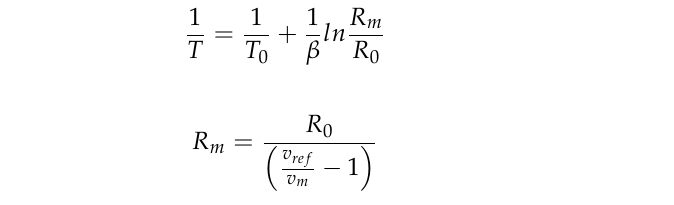
Figure 4. An in vivo measurement setup: ( a ) implanted coils underneath the skin, and ( b ) primary coils adhered above the skin. Table 3. The parameters used in Equations (6) and (7) to calculate the temperature from the recoded thermistor signals. Parameters